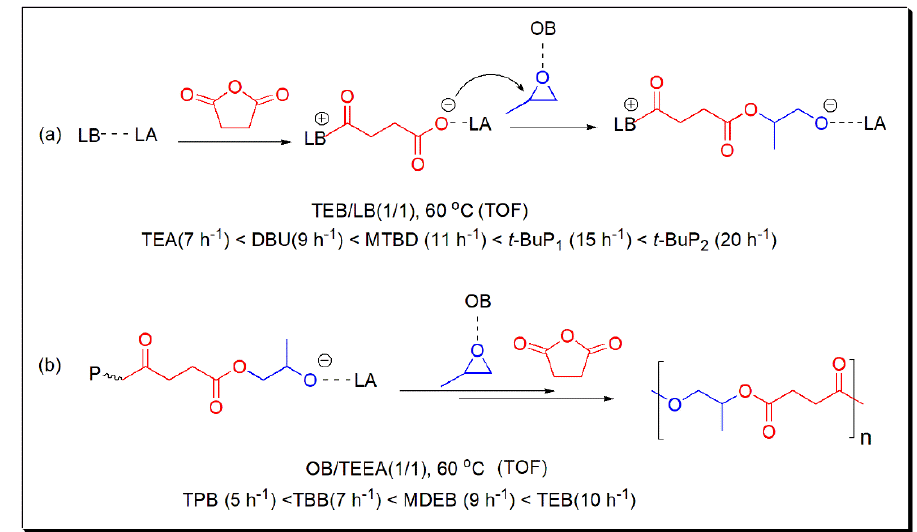
Figure 4. The effect of temperature on turnover of frequency (TOF) values and ester content of the SA/PO copolymerization catalyzed by TEB/ t -BuP 1 pairs with the molar ratio of ( A ) 1/1; ( B ) 4/1.